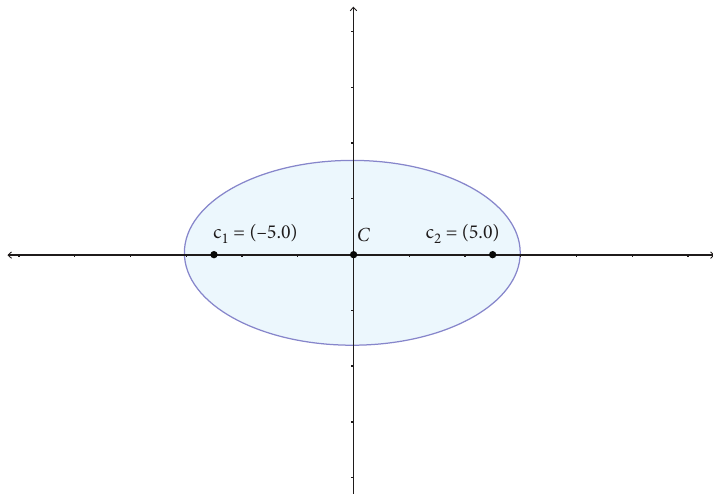
− 5, 0 Þ , ð 5, 0 Þ , 12 Þ centered at ð 0, 0 Þ having foci at ð − 5, 0 Þ and ð 5, 0 Þ is shown in this fi Figure 1: The elliptic disc E D ðð